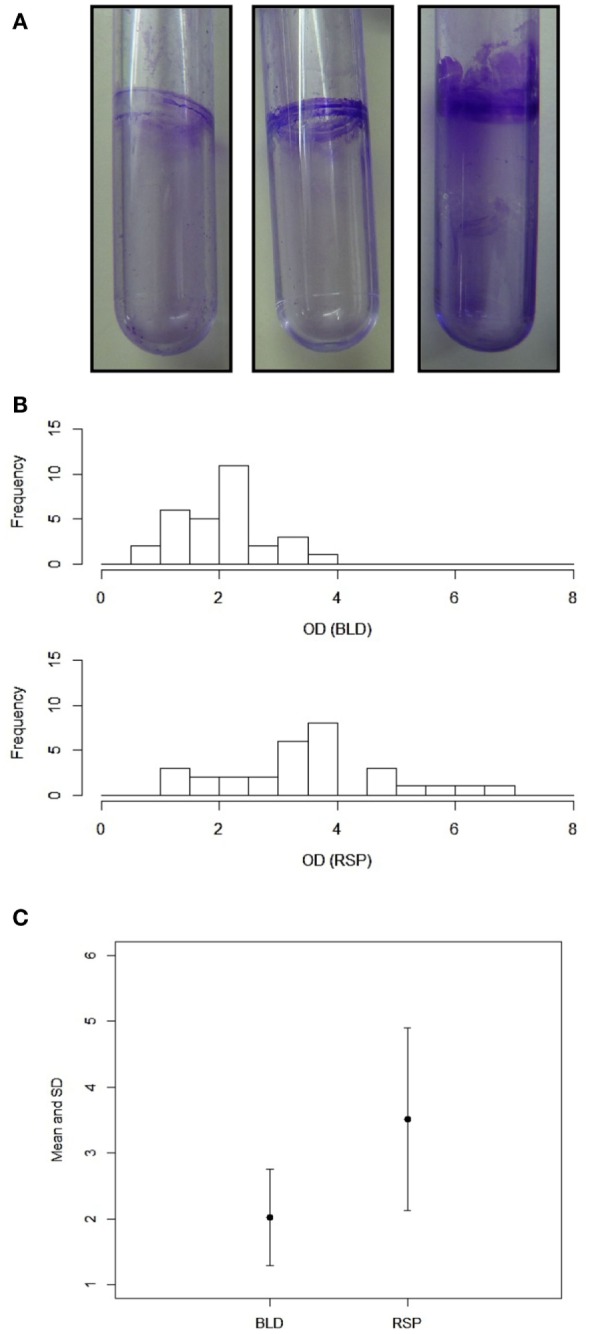
Biofilm formation by A. baumannii clinical isolates. (A) Representative polystyrene tubes with varying degrees of biofilms. Biofilms were stained with crystal violet after 2 days of incubation. (B) Quantitation of biofilm mass by crystal violet. Bar diagrams showing OD values (x-axis) against the number of isolates (y-axis). (C) Statistical analysis of the blood and respiratory isolates (p < 0.001). Values for mean and SDs are shown. Representations: BLD, blood isolates; RSP, respiratory isolates. Experiments were repeated at least three times.